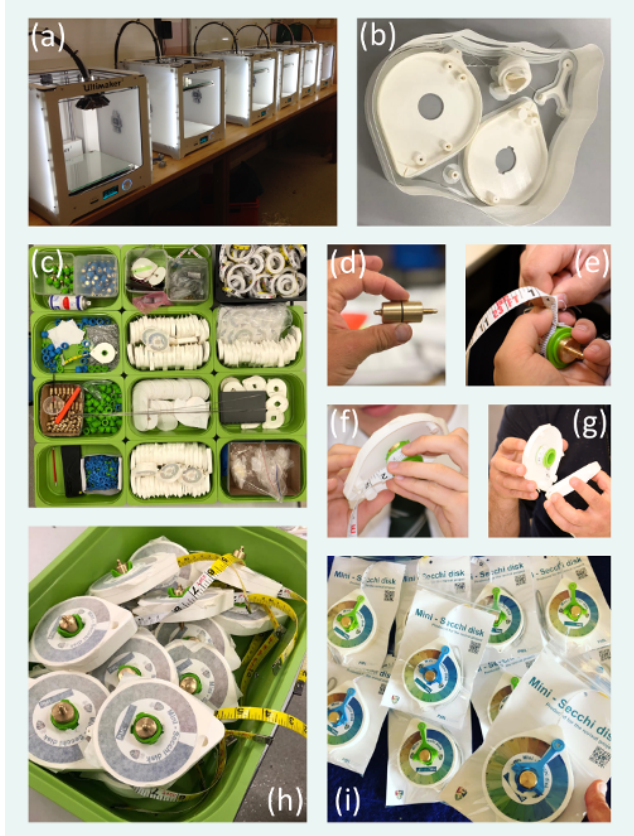
Figure 3. Photos of keys steps in the manufacturing process. ( a ) Ultimaker 2 printers used to 3D print components of the mini-Secchi disk. ( b ) An example 3D print of the casing, bobbin and handle of the mini-Secchi disk. ( c ) Assembly of the components of the mini-Secchi disk after 3D printing the parts and printing the vinyl colour scale sticker, manufacturing the weight and the Secchi disk, and procuring the measuring tape. ( d – g ) Constructing the mini-Secchi disk. Having manufactured the weight ( d ), using either a metal lathe or a CNC machine, and bobbin (glued and finished), the weight is fitted into the bobbin and the measuring tape is stitched onto the bobbin ( e ). The bobbin is fitted into the casing ( f ) and measuring tape enclosed between the two sides of the casing ( g ) before being locked in place with the finger strap using the fittings. ( h ) The colour scale sticker is added before the handle of the device is fitted, lanyard added, and disk and weight attached to the measuring tape. ( i ) Examples of mini-Secchi disks produced for the REVIVAL project